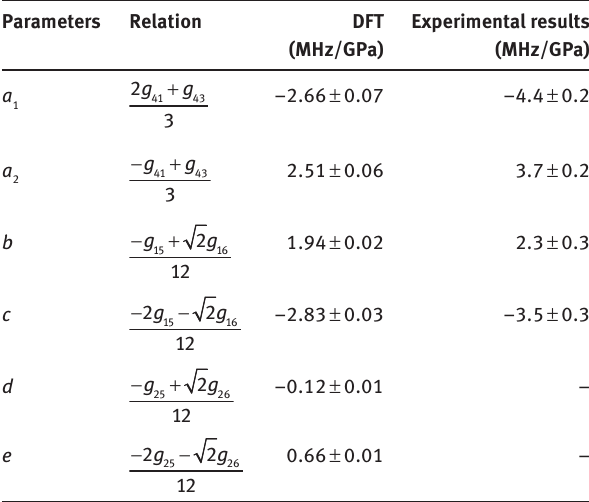
Table 3: Spin-stress coupling-strength parameters in the ground state: comparison of DFT [237] and experimental [247]